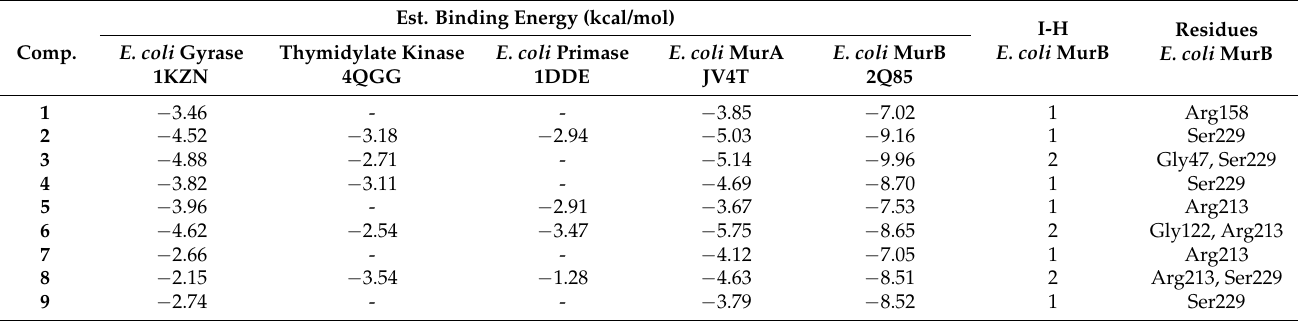
Table 4. Molecular docking free binding energies (kcal/mol) to antibacterial targets.